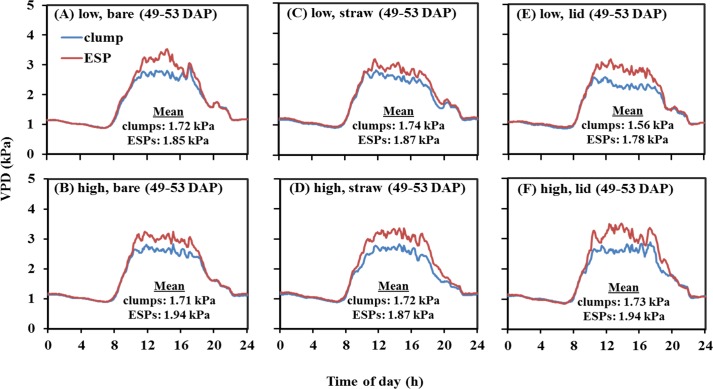
Average 5-day vapor pressure deficit (VPD) mean within the plant canopy recorded every five minutes for different treatments in 2014 at 45–53 DAP corresponding to booting growth stage.DAP: days after planting; ESPs: evenly spaced plantings. The mean VPD is derived from the average of 4320 data points.